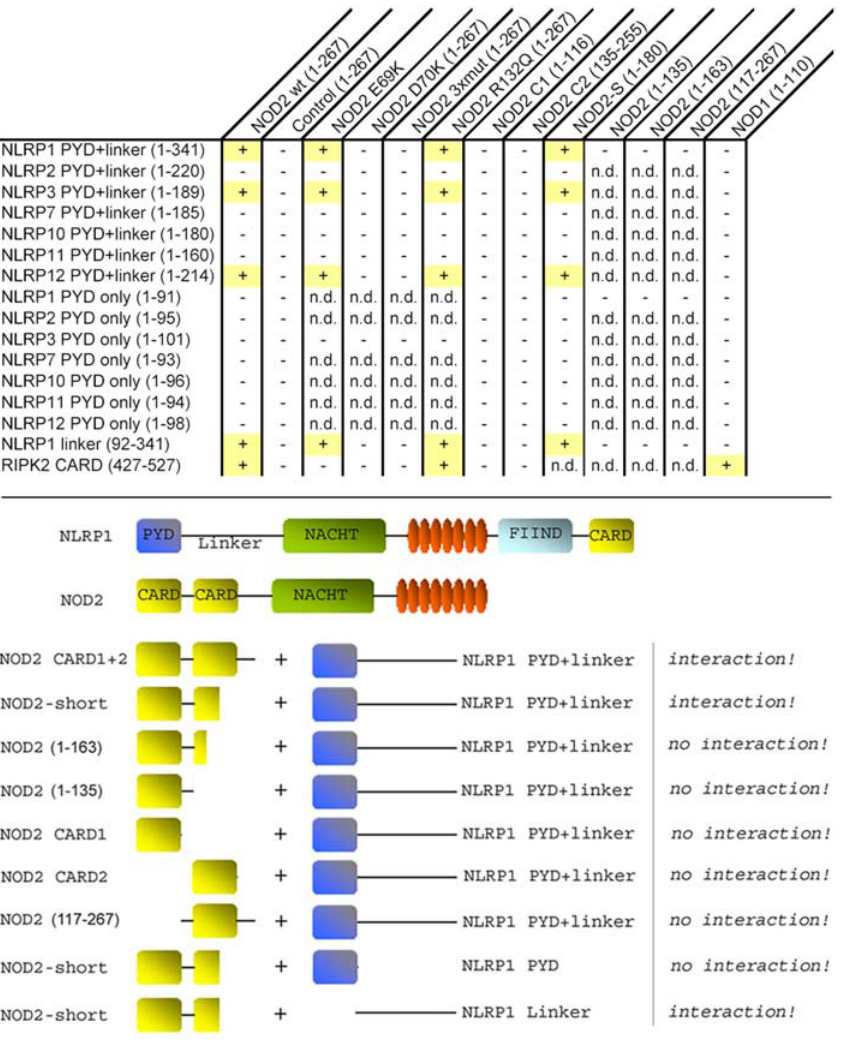
Table 2. All constructs were sequenced by MWG Biotech (Germany) and subsequently subjected to yeast two-hybrid analysis.